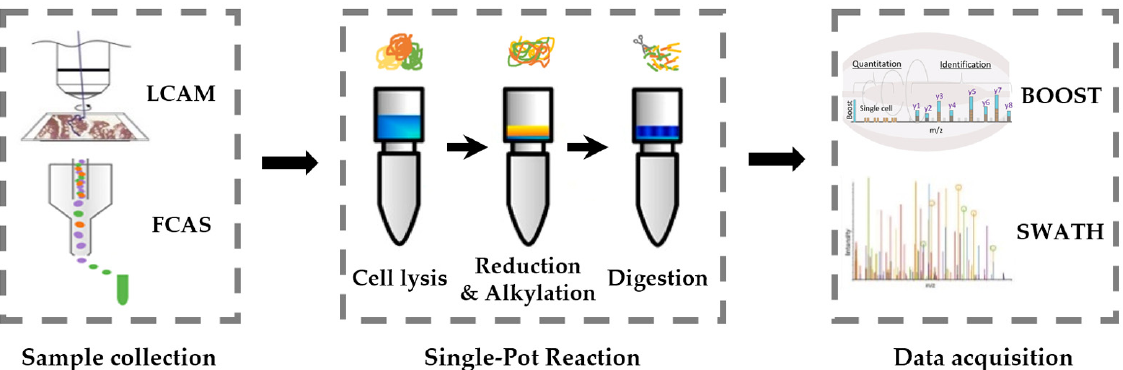
The method of low cell number proteomics contributes to spatial-resolved kinases [118]. Multicellular organisms contain specialized cell types with unique functions and morpho- logical features. The specialization is caused by differences in protein expression [119]. Different cell states may respond differently to the same exogenous signal. Even within the same cell type, the response may differ. Therefore, the spatial and cell type information can be linked with the kinome by analyzing a small number of cells. The spatial kinome can provide insight into the tissue microenvironment and uncover more precise biomarkers and new functional mechanisms [120]. Unlike single-cell analysis at the genomic and tran- scriptomic level, low cell number proteomic analysis cannot rely on techniques that allow amplifying trace amounts of protein [121]. Therefore, massive innovations and technolo- gies [122] have been developed and applied in sample preparation and mass spectrometry detection, which make kinome analysis on paucicellular samples possible (Figure 7).